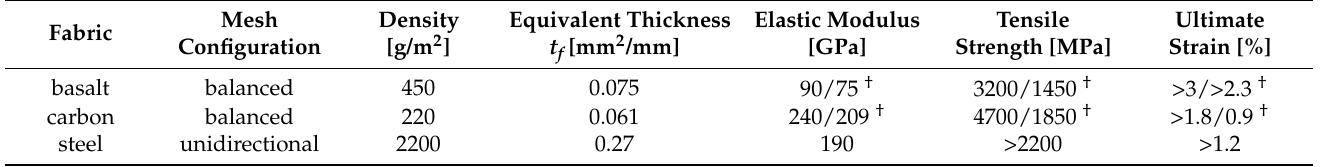
Table 1. Physical and mechanical properties of the fabrics used in the FRCM